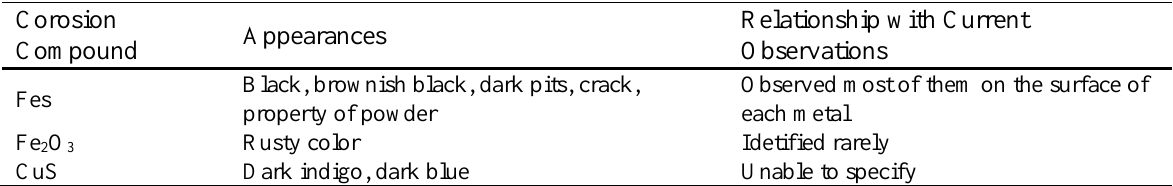
Table 4. The descriptive summary about corrosion compounds.